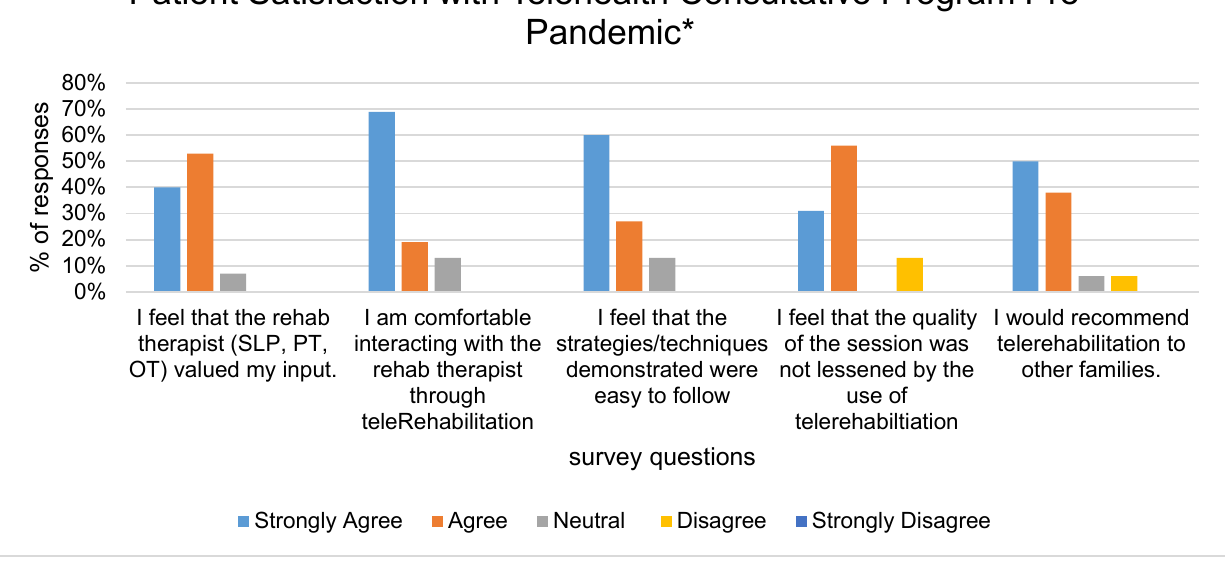
Patient Satisfaction with Telehealth Consultative Program Pre-Pandemic